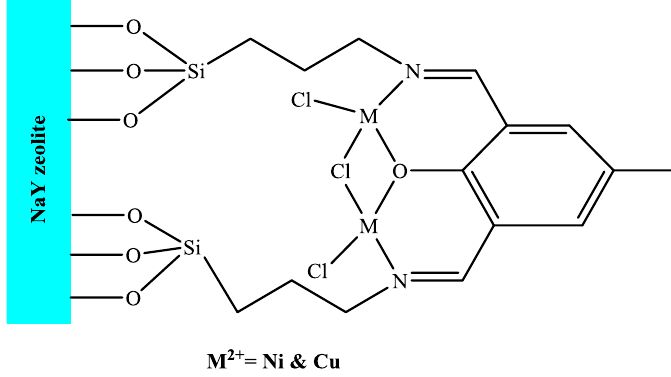
Figure 6. Schematic pattern of immobilization of 2,6-diformyl-4-methylphenol (DFP) complexes [102].